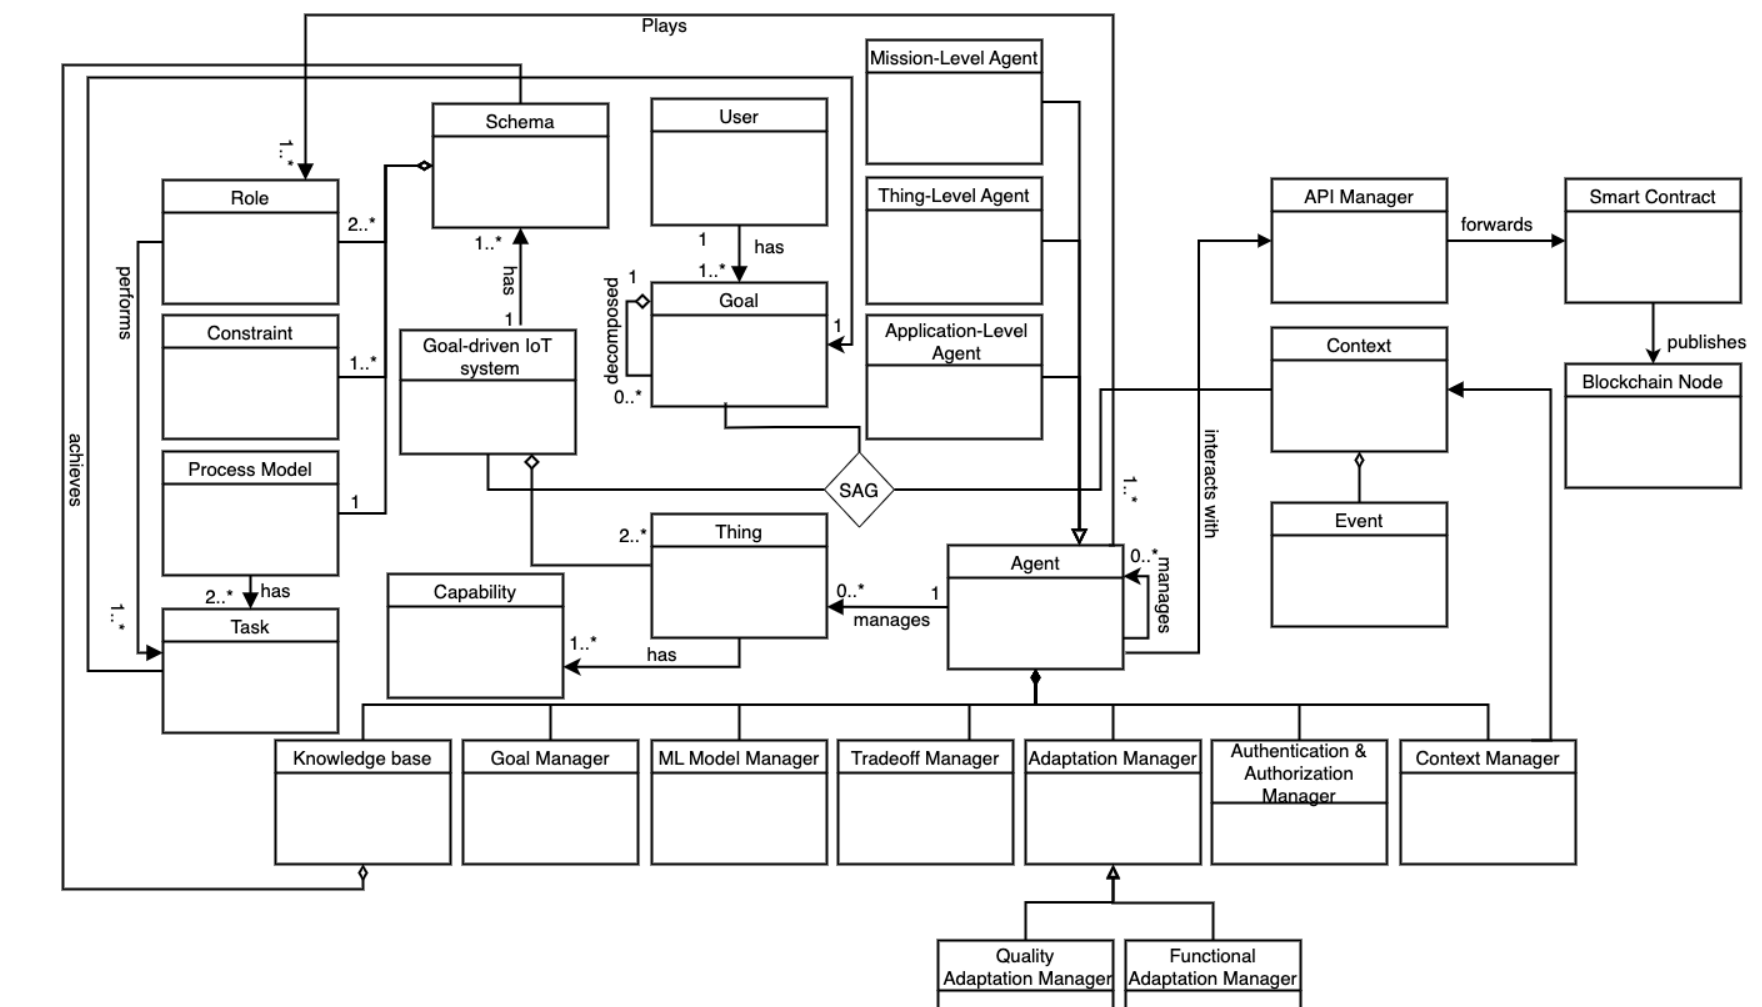
Figure 5. The logical view of our architecture represented in a UML class